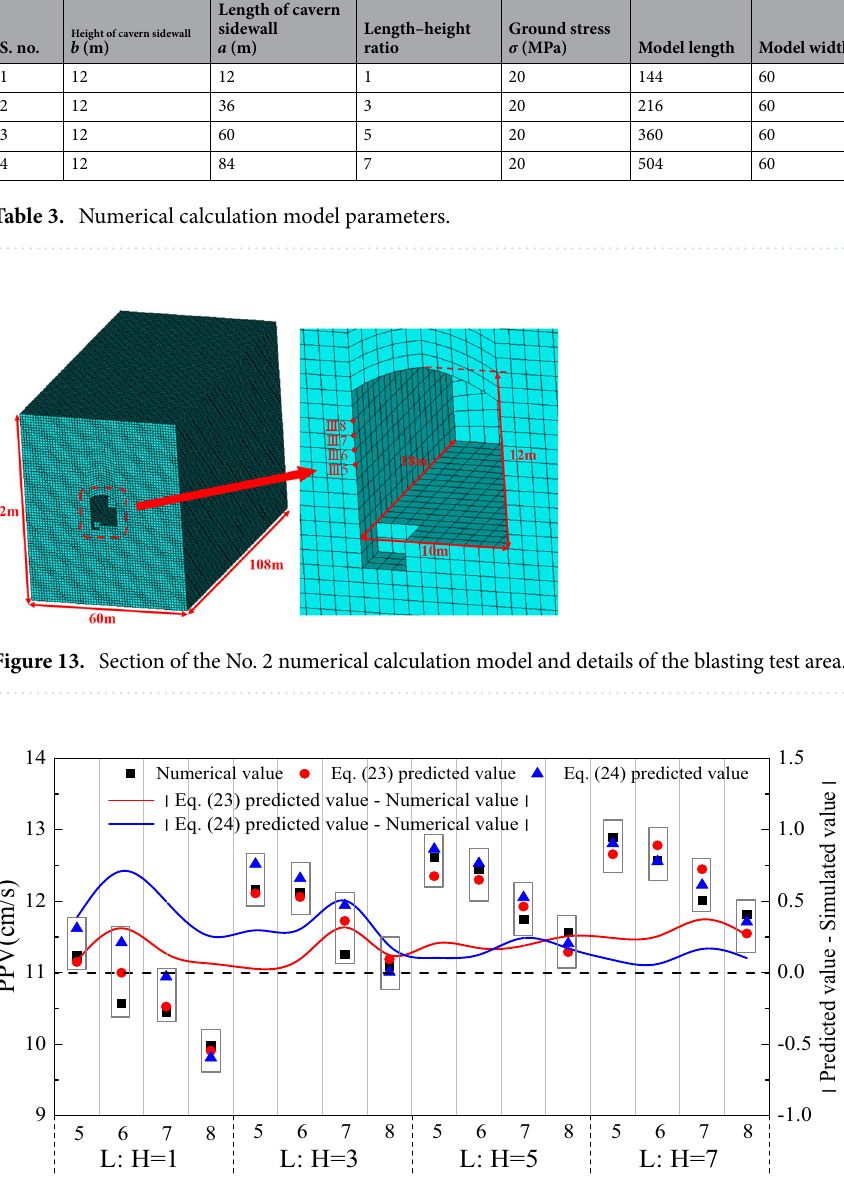
Figure 14. Influence of different length–height ratios on sidewall PPV and values predicted by two